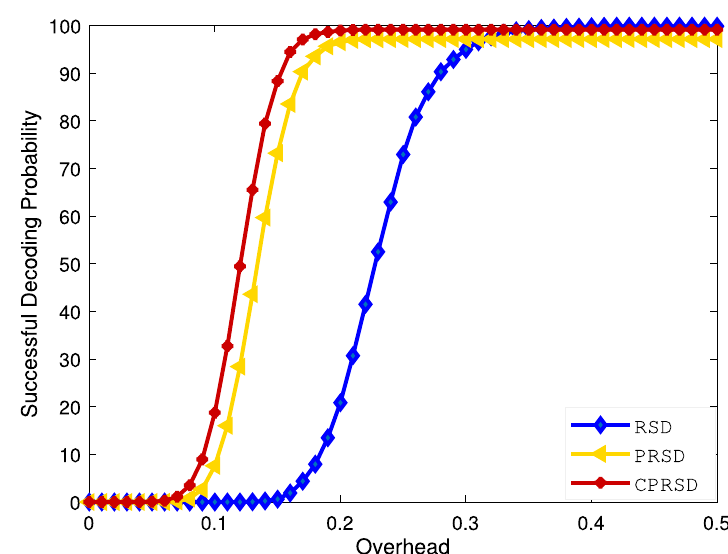
Fig. 10 Successful decoding probability for k = 500 in non-removal state